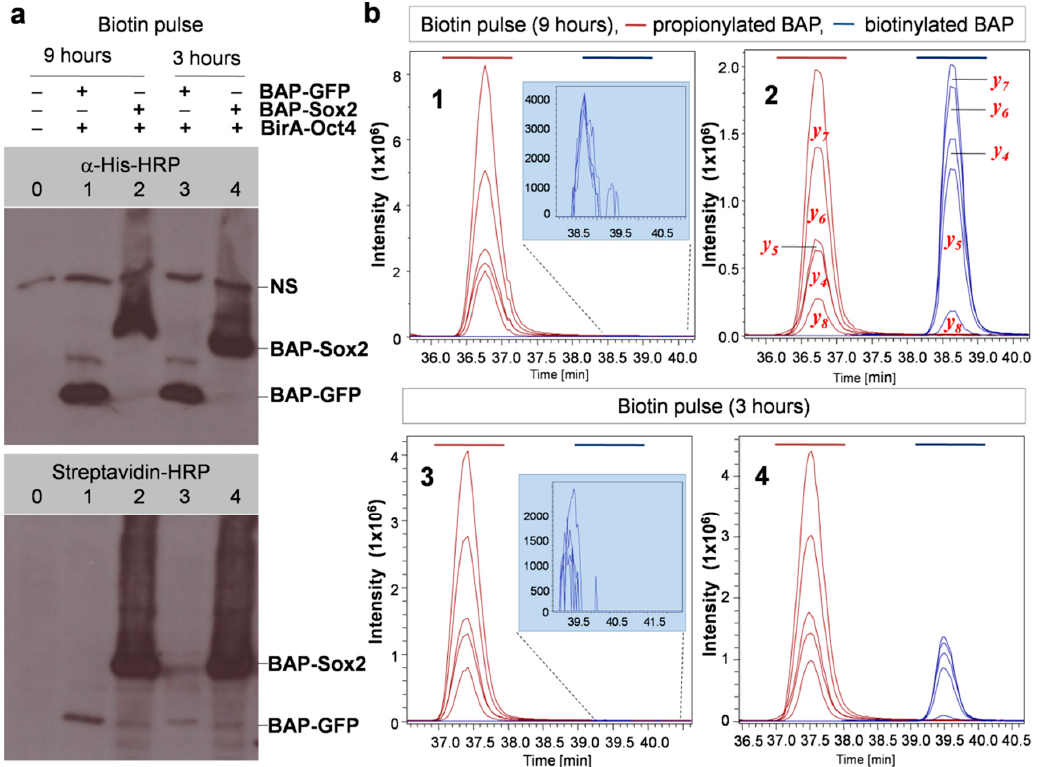
Figure 4. The biotinylation levels are interaction/proximity-dependent. ( a ) Western blotting to detect the interaction of pluripotency transcription factors versus a control at two biotin pulse times. Combinations of BirA and BAP fusion proteins were transfected separately into cells: lanes 1 and 3: BAP-GFP + BirA-Oct4 (control), lanes 2 and 4: BAP-Sox2 + BirA-Oct4, 0: nontransfected cells, NS: nonspecific signal. ( b ) Multiple reaction monitoring (MRM) detection of propionylated and biotinylated BAPs. Shown are extracted ions chromatograms for the most intensive fragmentation ions present in the MS/MS spectra of the respective peptides (y-series). Note the change of peaks corresponding to biotinylated BAP (colored blue) relative to propionylated BAP (colored brown) at different biotin pulse times (sample 2 and sample 4). Numbers in the graphs correspond to the lane numbers in the Western blots.